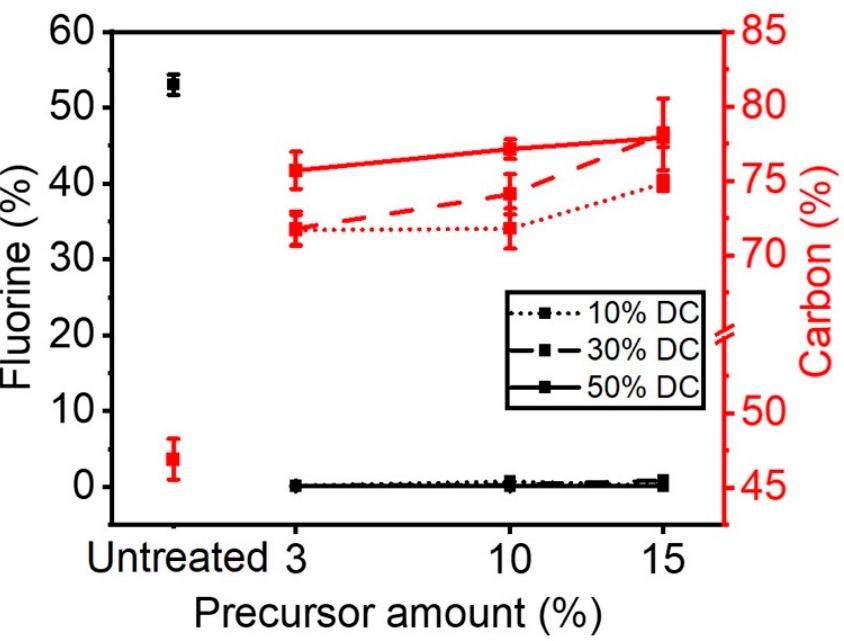
Figure 2. Carbon and fluorine surface concentration as a function of precursor amount and DCs